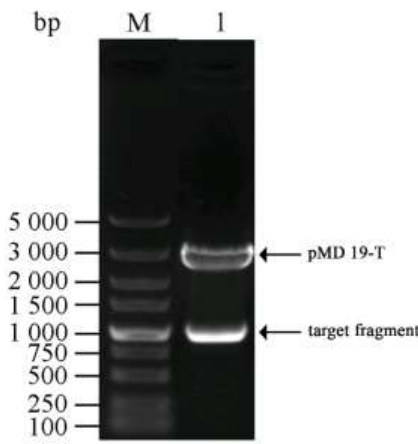
Figure 2. Confirmation the cloning vector by restriction enzyme digestion M: DL5000 DNA Marker; 1: The products of pMD19-T- ChiKJ406136 -1 vector restriction enzyme digestion.